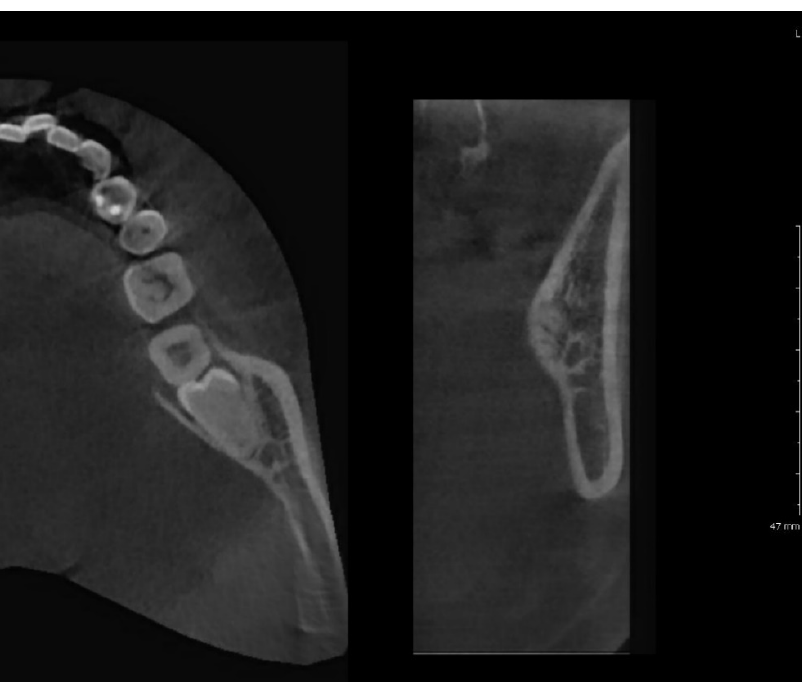
Figure 4. Patient 1801222, the CBCT confirms the nearness of the root of the wisdom tooth with the lingual cortical plate with an impaction of − 1 mm. Axial plan on the left and cross-section plan on the right.